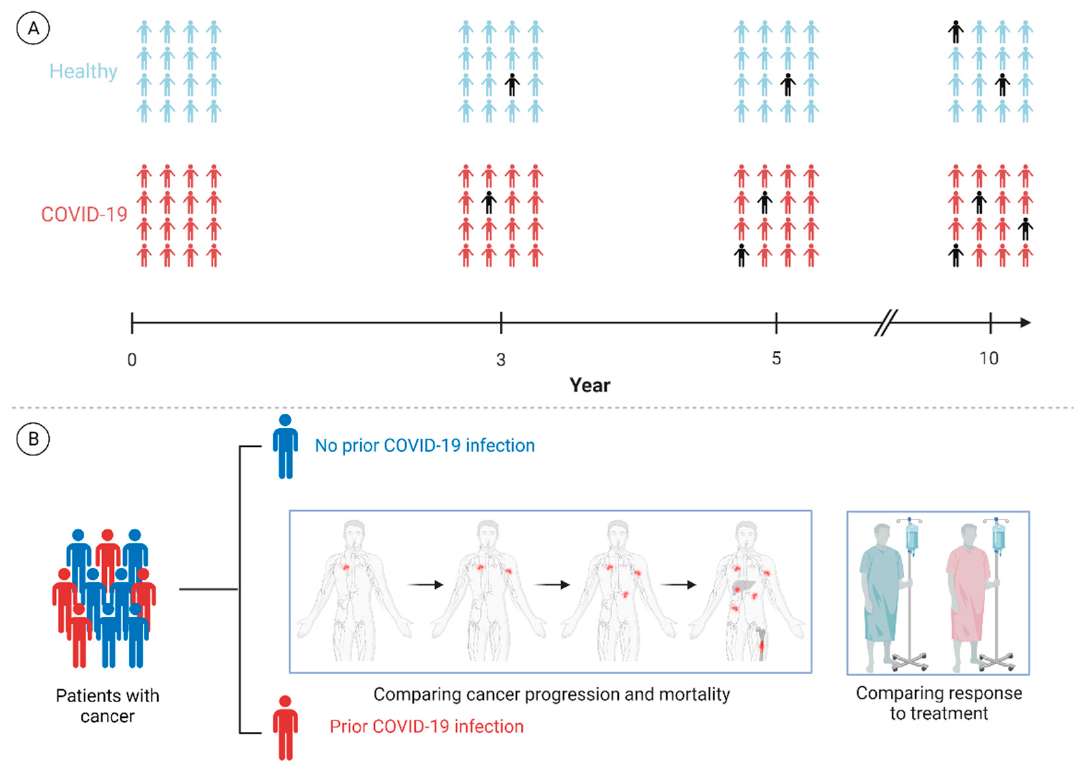
Figure 5. Proposed framework for clinical and population-based investigations. ( A ) Studies that can investigate whether prior COVID-19 infection is a risk factor for development of malignancies in subsequent years. ( B ) Other investigations could also shed light on the potential long-term effects of SARS-CoV-2 antigens present in cancer tissues on cancer progression and mortality rate and the response to different cancer therapeutics. The back icon in ( A ) represents a patient with a new diagnosis of cancer. Please note that the numbers of individuals with cancer in both groups have been arbitrarily chosen and are not based on real-life data. Future investigations will hopefully examine the hypothesis described here.